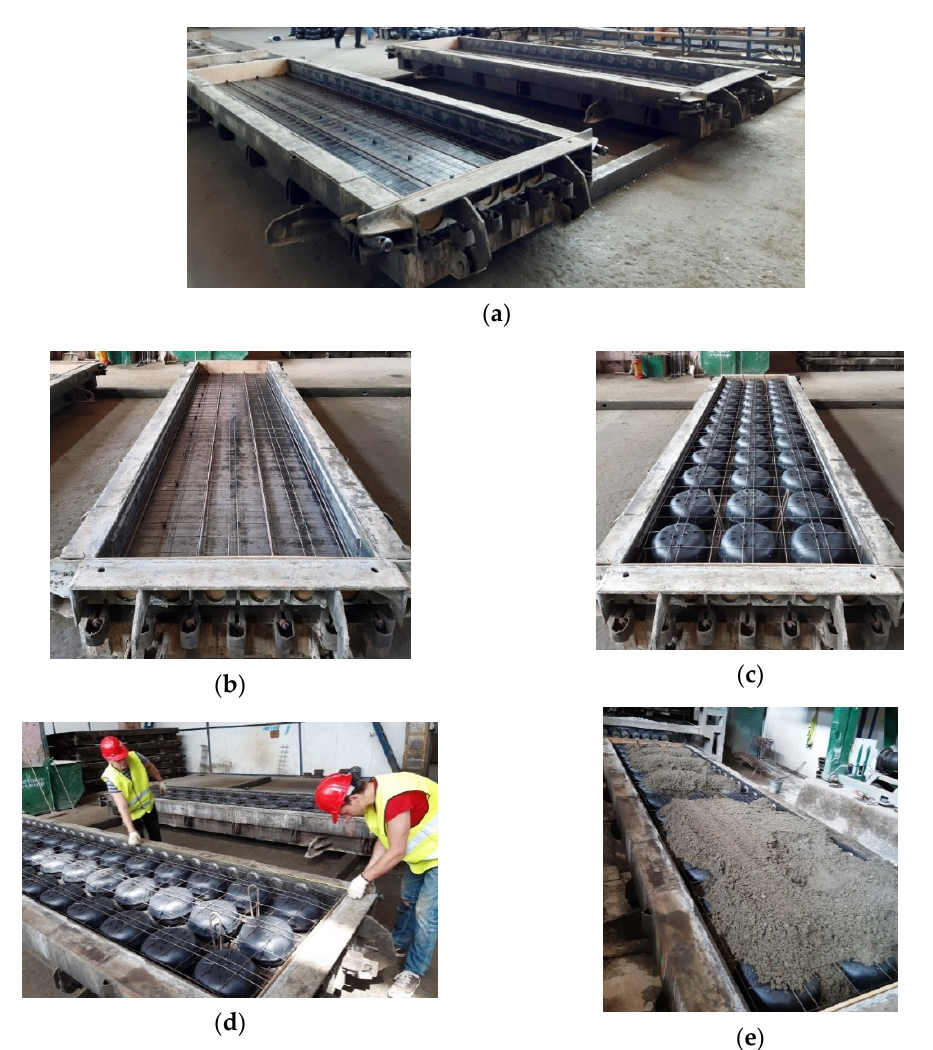
Figure 2. Manufacturing of tested slabs. ( a ) Slab moulds, ( b ) mould with lower slab reinforcement net, ( c ) mould with void-forming inserts and reinforcement, ( d ) moulds prepared for concreting, ( e ) concreting.